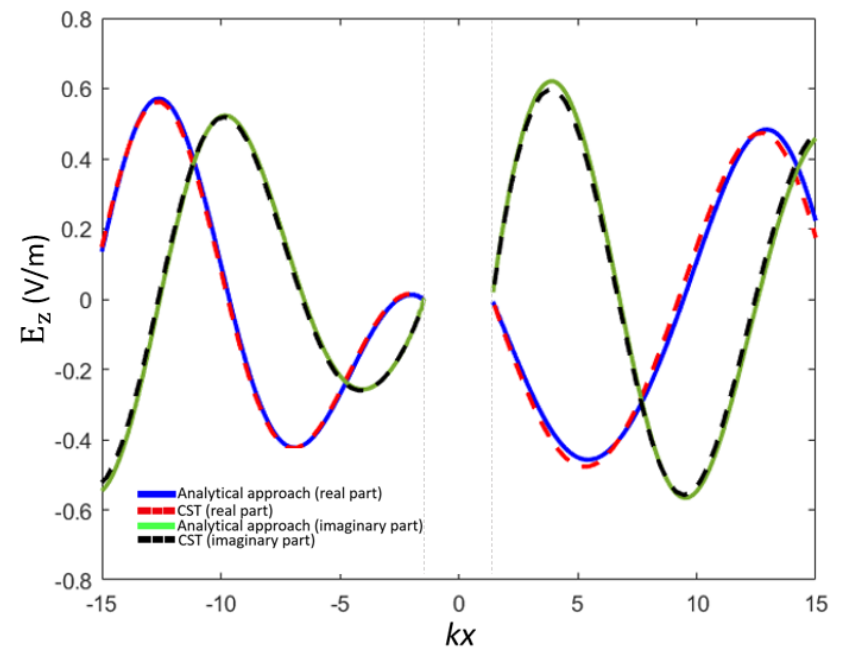
Figure 14. Real and imaginary parts of E z : comparison between the analytical approach implemented in Matlab and CST Microwave Studio, for the geometry of Figure 2. TM